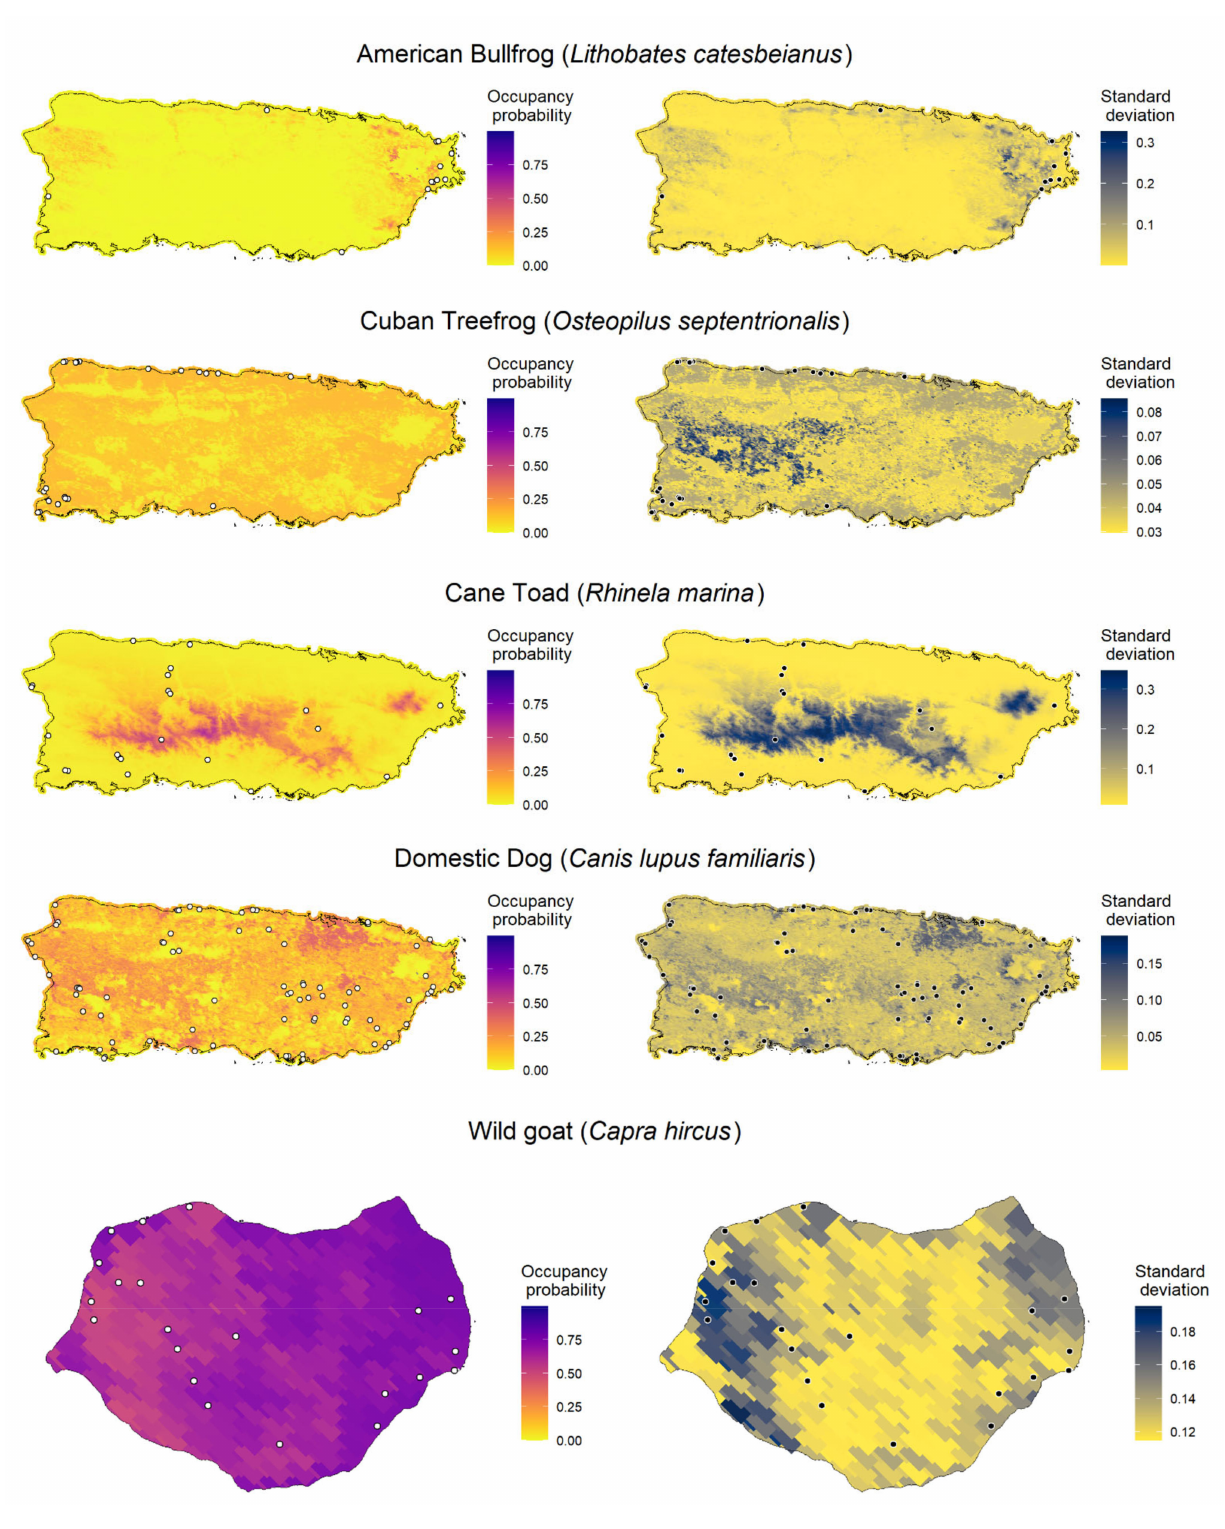
Figure A18. Cont